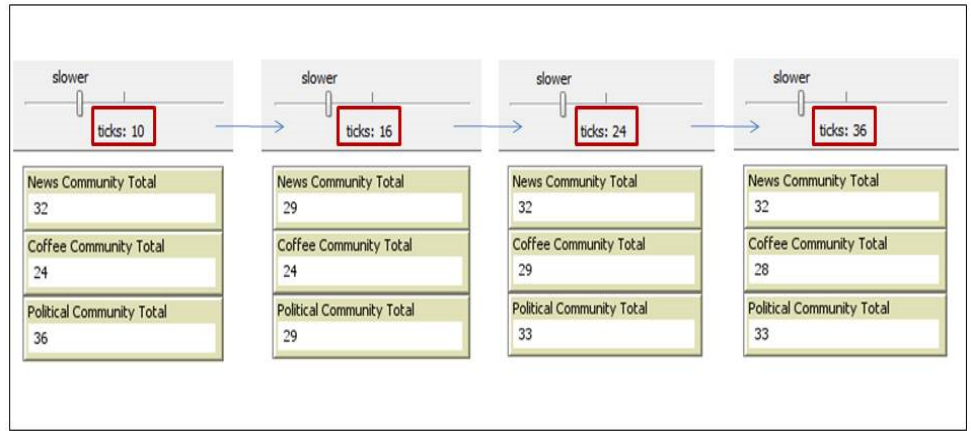
Figure 9. Number of objects in different communities over a period of time.